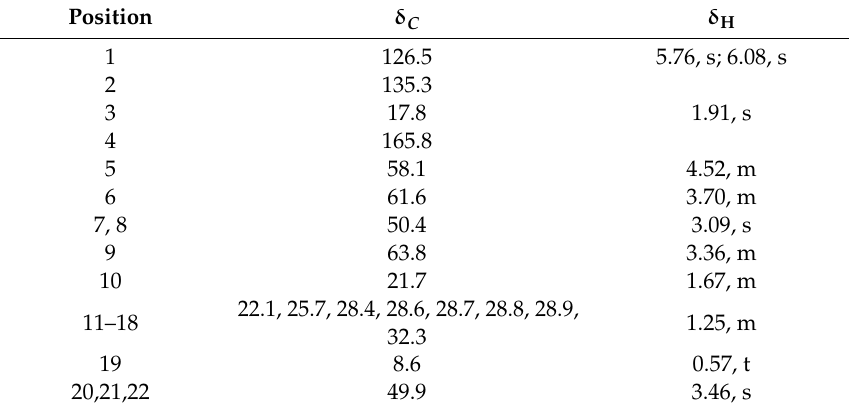
Table 4. NMR spectral peak assignments of AMsil2